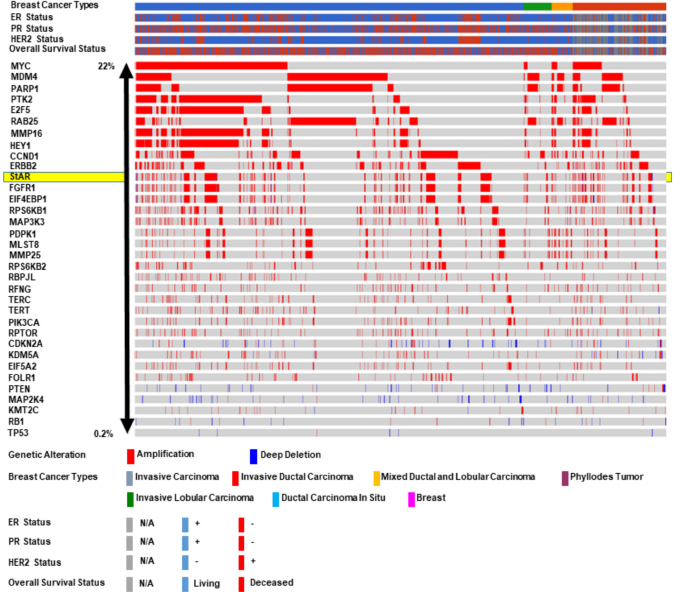
Figure 5. Amplification of various genes that are frequently occurred in BCs. TCGA METABRIC breast tumor samples (N = 2173) categorized in different groups (bottom panel) were analyzed for amplification of various targeted genes (illustrated at left panel). Clinical features, including ER, PR, and HER2, as well as overall survival statuses, are shown in left/bottom panels. Copy number alteration ranged from 22% (higher) to 0.2% (lower). Alteration of genes studied are the following: MYC , MDM4 , PARP1 , PTK2 , E2F5 , RAB25 , MMP16 , HEY1 , CCND1 , ERBB2 , StAR , FGFR1 , EIF4EBP1 , RPS6KB1 , MAP3K3 , PDPK1 , MLST8 , MMP25 , RPS6KB2 , RBPJL , RFNG , TERC , TERT , PIK3CA , RPTOR , CDKN2A , KDM5A , EIF5A2 , PTEN , MAP2K4 , KMT2C , RB1 , AND TP53 . Both amplification (red) and deep deletion (blue) are